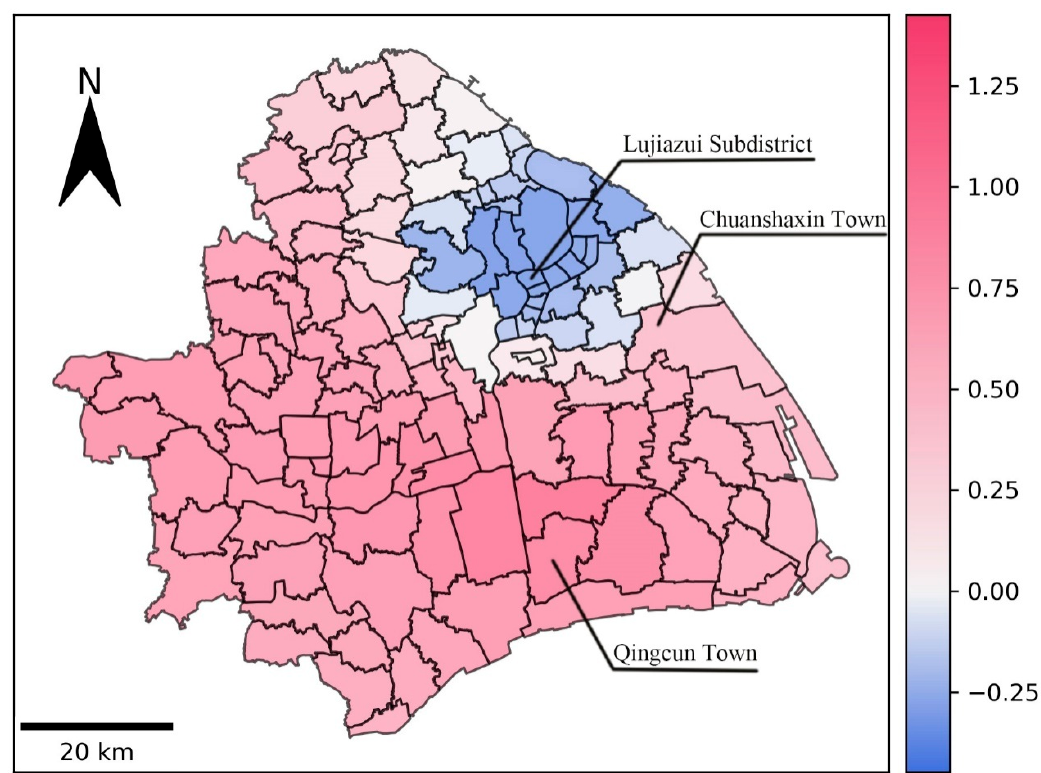
Figure 8. The surface of the regression coefficient for the average plot ratio in the MGWR model.